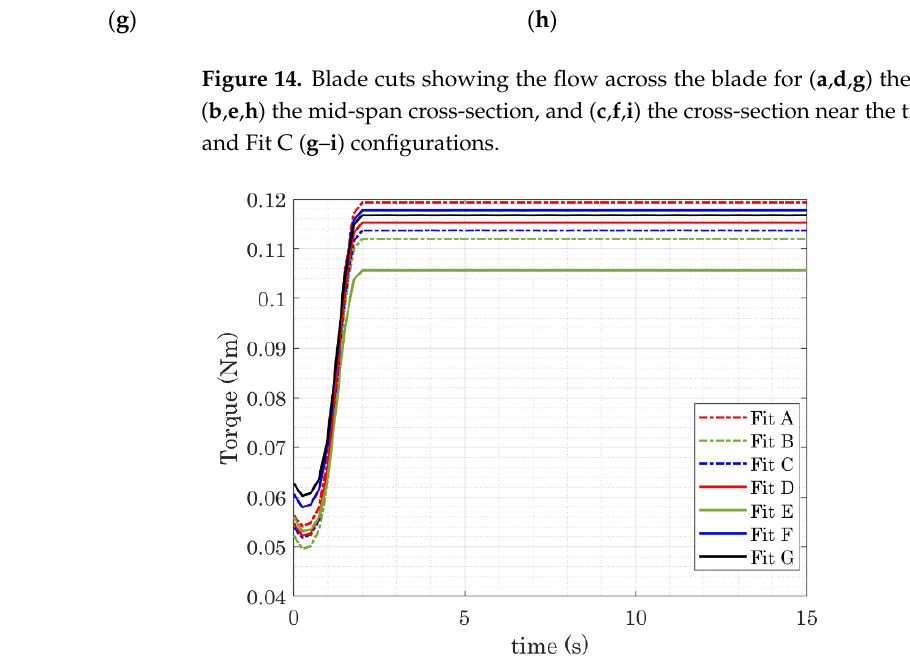
Figure 15. The steady-state torque obtained for different twist distributions. Table 8. Power generation for the studied twist distributions.